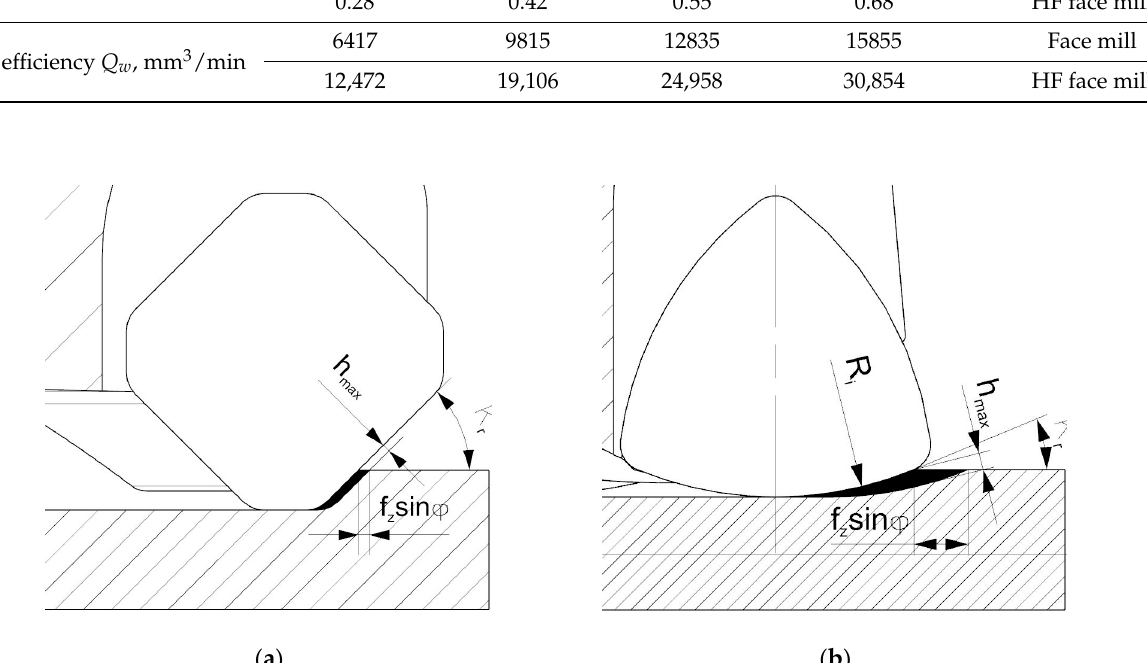
Figure 4. Cut layer cross-section for milling with: ( a ) conventional cutter, ( b ) HF cutter.